Question: In one sentence, what is this figure communicating?
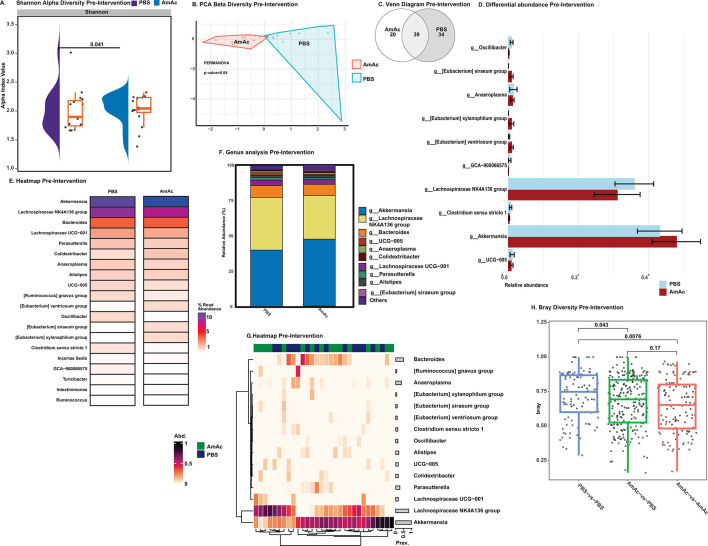
Answer: Percent read abundance of taxa (vs baseline PBS-UA group) a